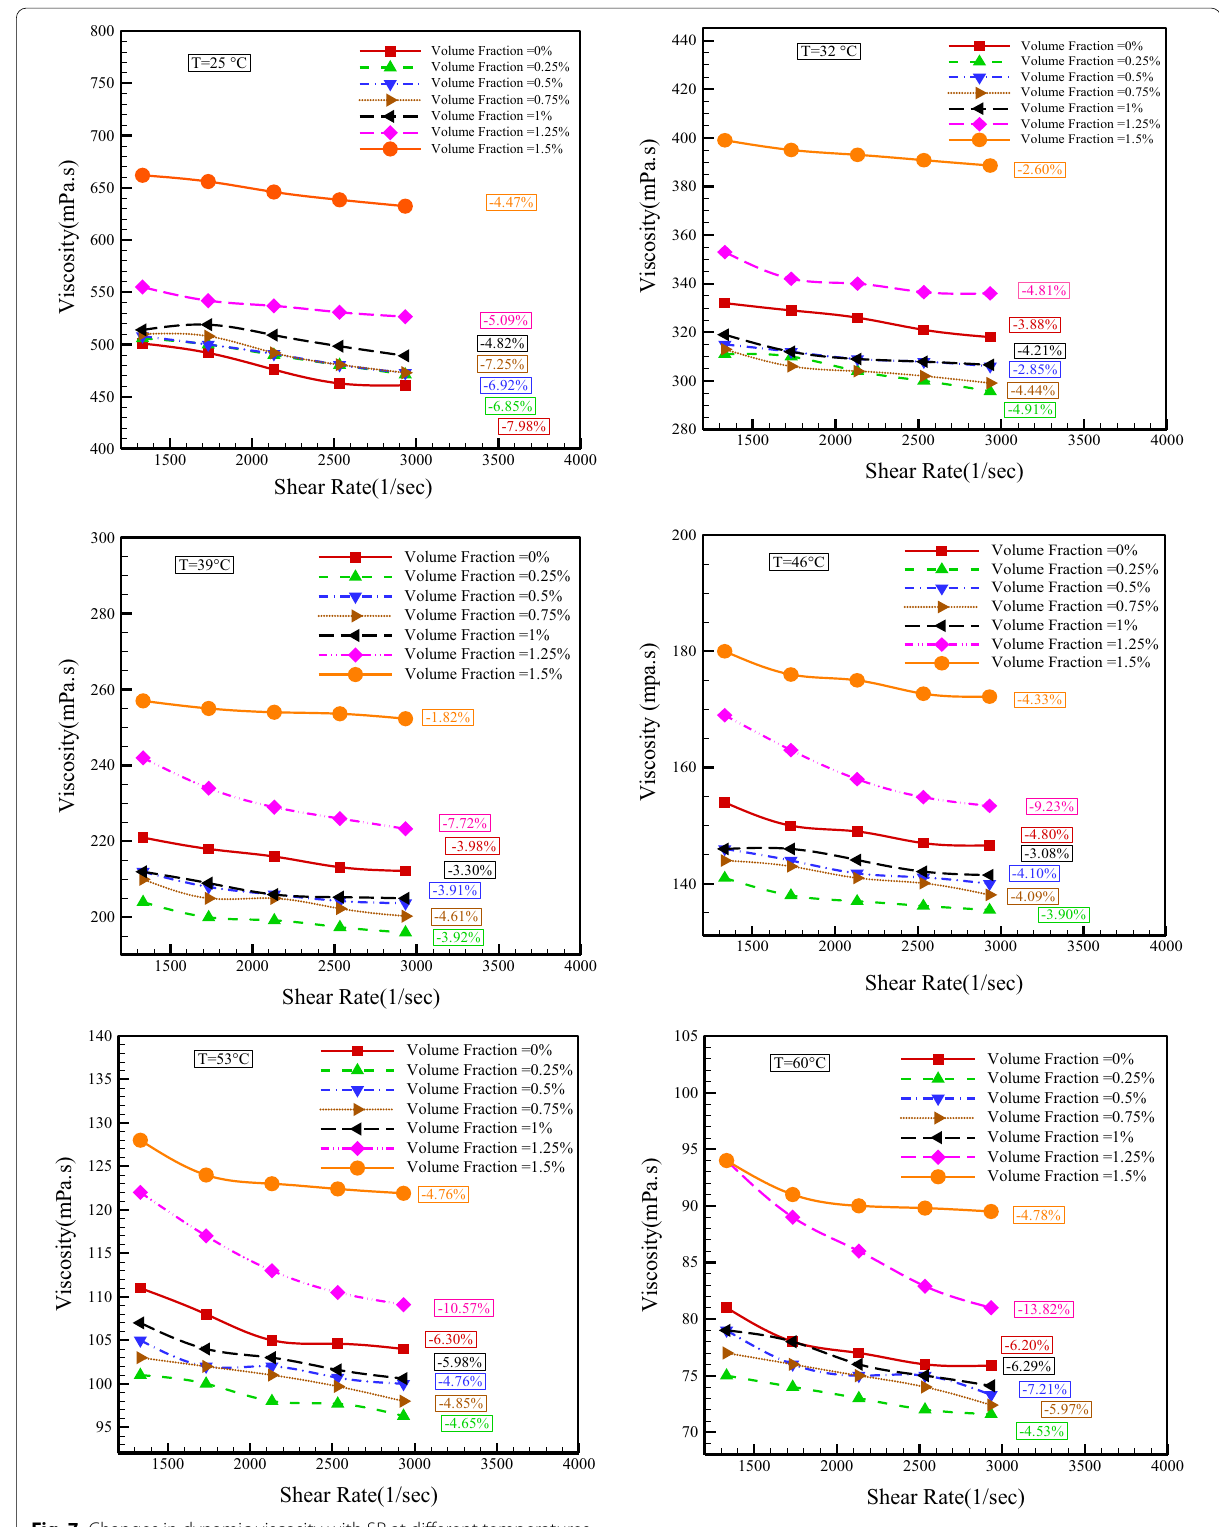
Fig. 7 Changes in dynamic viscosity with SR at different